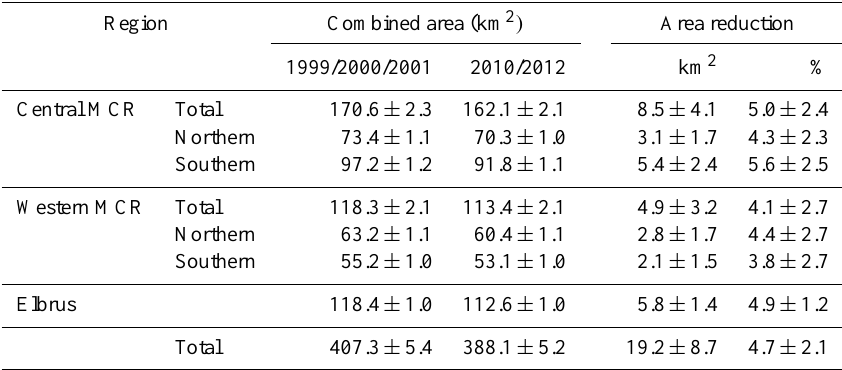
Table 2. Changes in glacierized area.